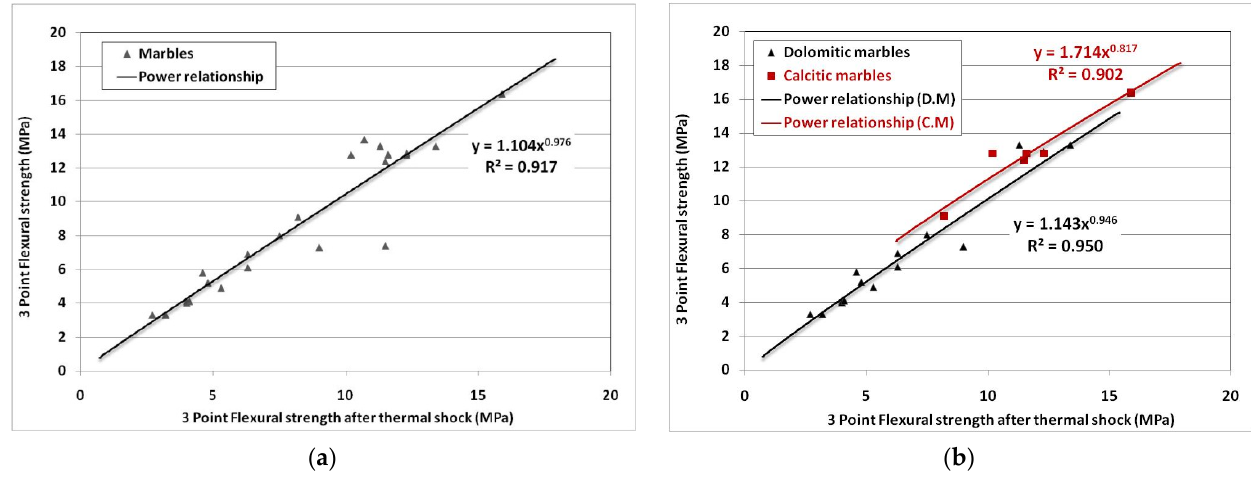
Figure 4. ( a )Overall correlation between FS 3 and TSFS 3 . ( b )Correlation equations between FS 3 and TSFS 3 . Figure 4. ( a ) Overall correlation between FS 3 and TSFS 3 . ( b ) Correlation equations between FS 3 and TSFS 3